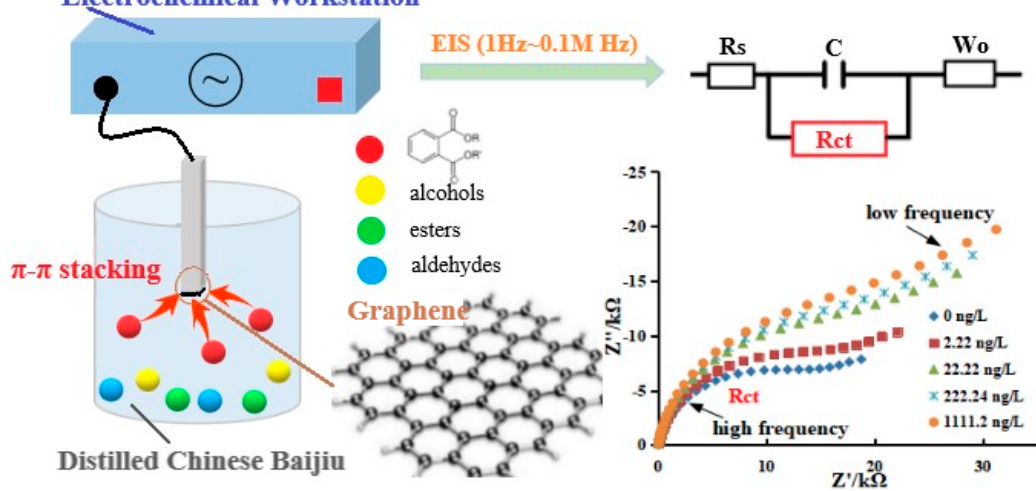
Figure 1. A schematic diagram illustrating the basic strategies of in situ preconcentration and detection of PAEs in Chinese liquor with electrochemical impedance spectroscopy.